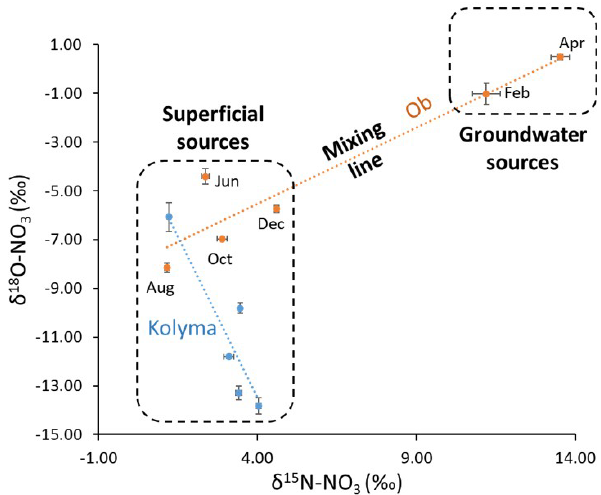
Figure 8. Likely different sources of nitrate throughout the year in the Ob and Kolyma catchments inferred by relationships between δ 15 N-NO − and δ 18 O-NO − . A mixing line can be plotted as a re- 3 3 gression line between the two sources. The location on the plot that each sample occurs can indicate the dominant nitrate sources at that time, and from that, the processes occurring can be